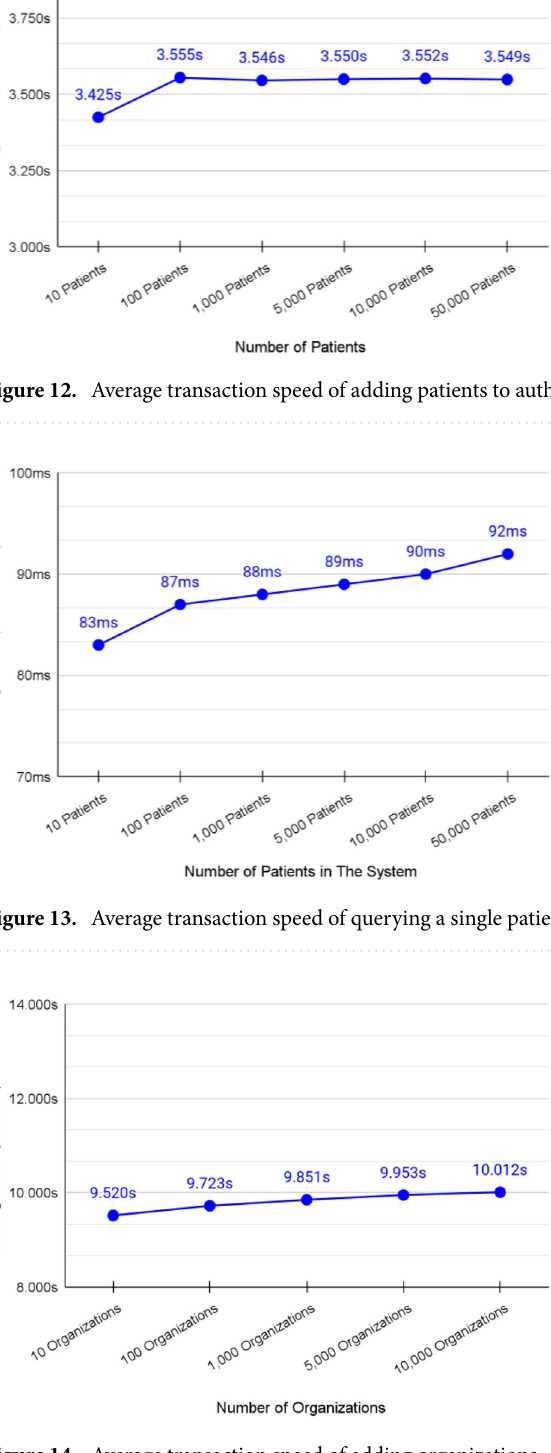
Figure 14. Average transaction speed of adding